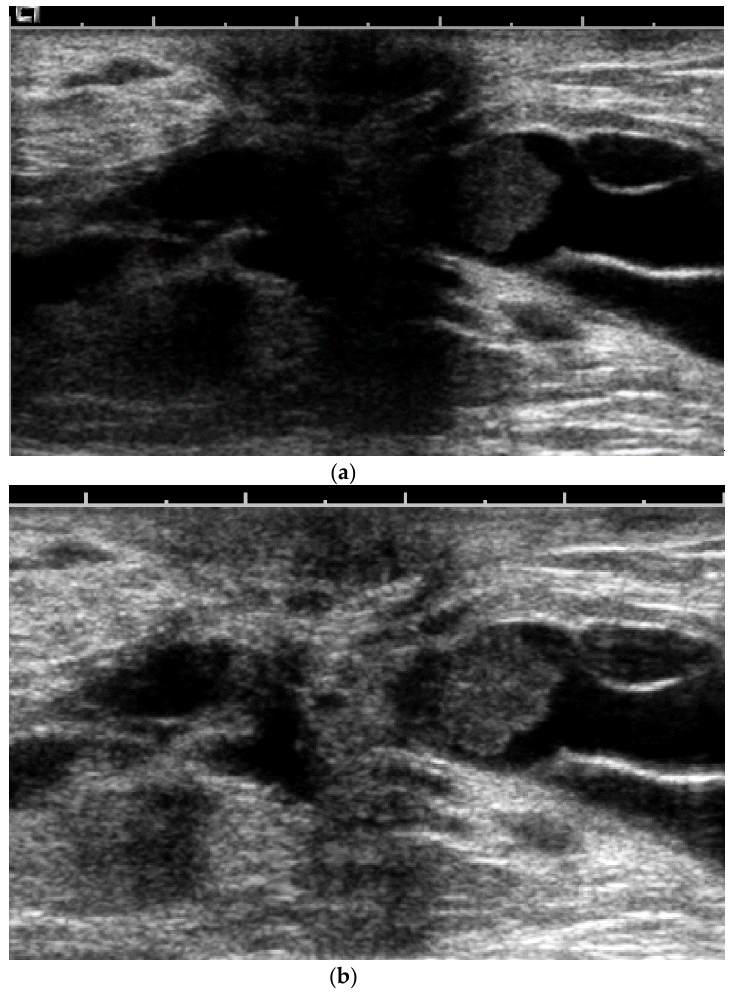
Figure 7. US image of an intra-ductal papilloma. Image ( a ), using Tissue Harmonic Imaging shows evidence of posterior acoustic shadowing generated by the nipple. Image ( b ) shows that the posterior shadowing significantly decreases with use of frequency compounding imaging, with a better visibility of the retroareolar region.